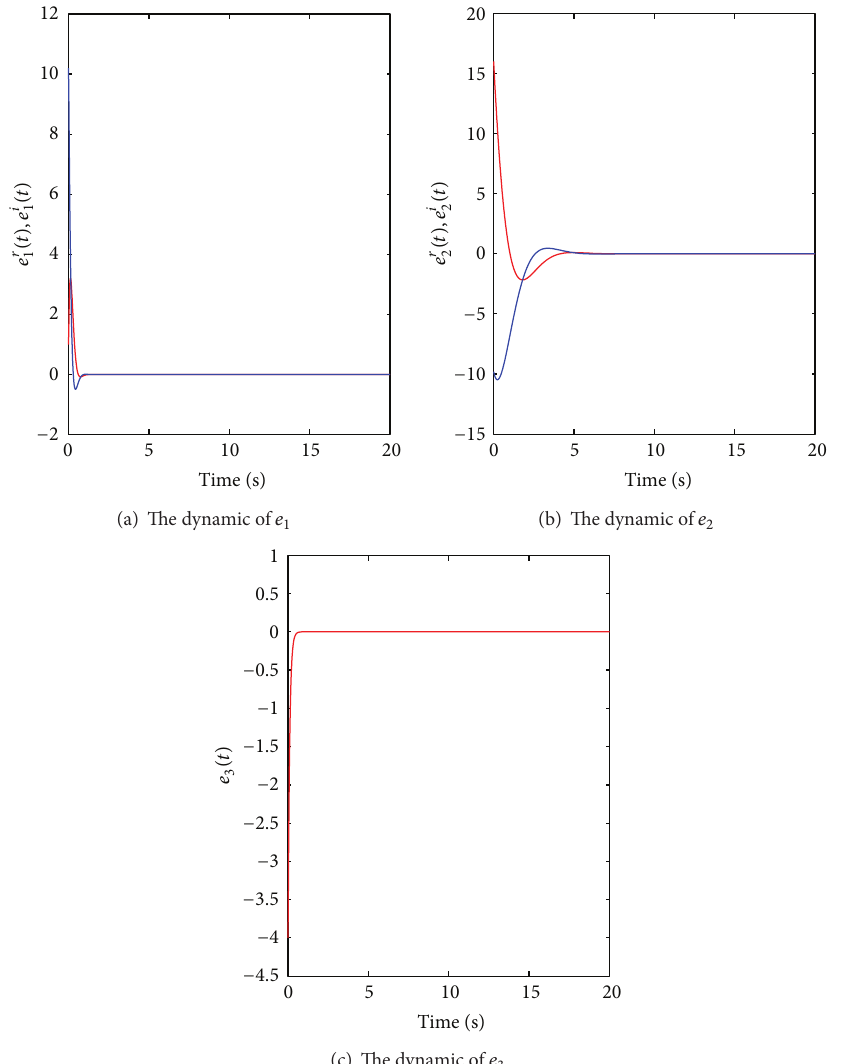
Figure 7: CMHPS error dynamics between 4-dimensional complex hyperchaotic Dadras drive system (29) and 3-dimensional complex chaotic Lorenz response system